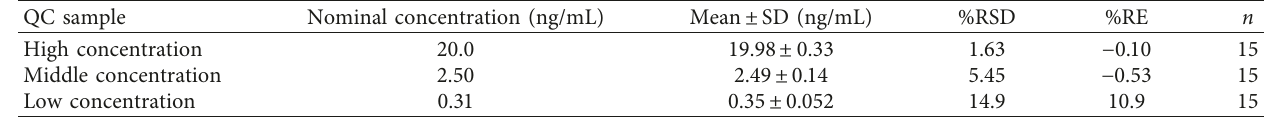
Table 1: Interassay accuracy and precision of the applied analytical method.